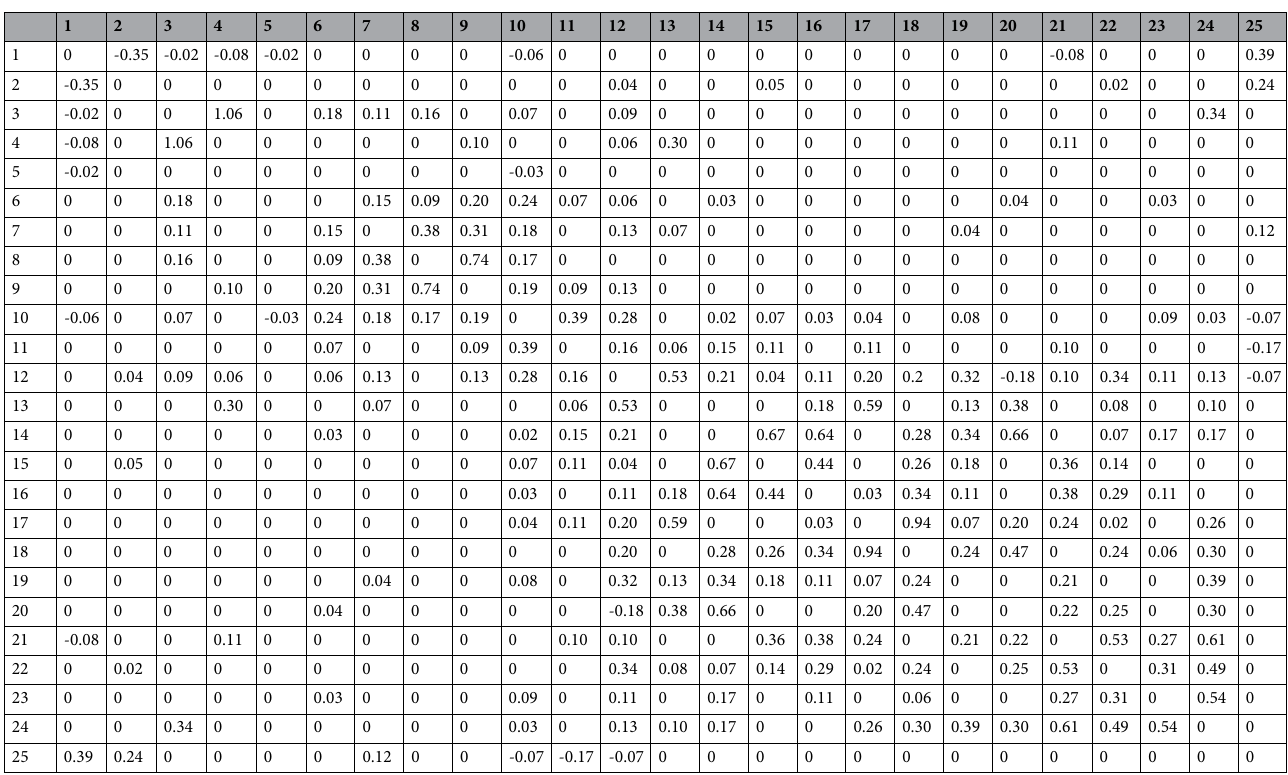
Table 2. Edge weights for the network shown in Fig. 1 (obtained via mixed graphical-model estimation). Node labels : 1 = age of cannabis use initiation, 2 = lifetime cumulative frequency of cannabis use, 3 =